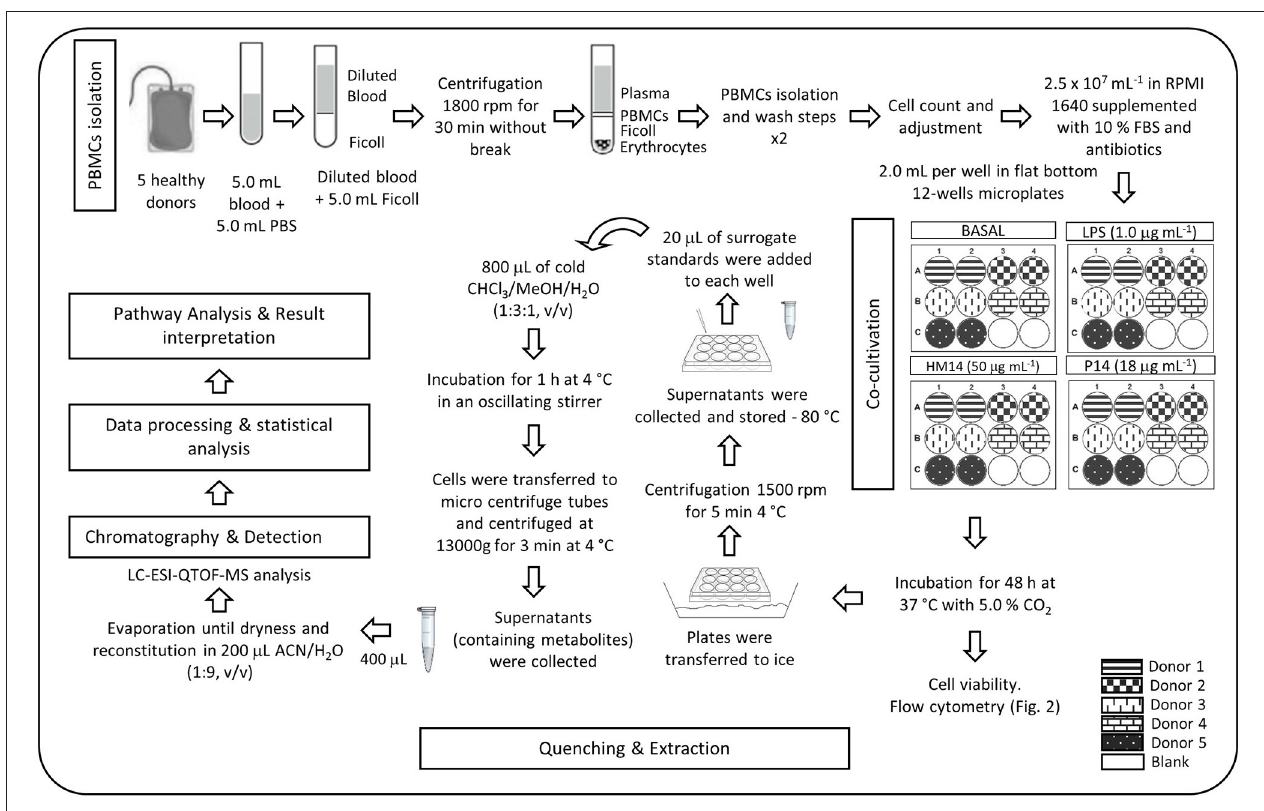
FIGURE 1 | Diagram flow of the experimental